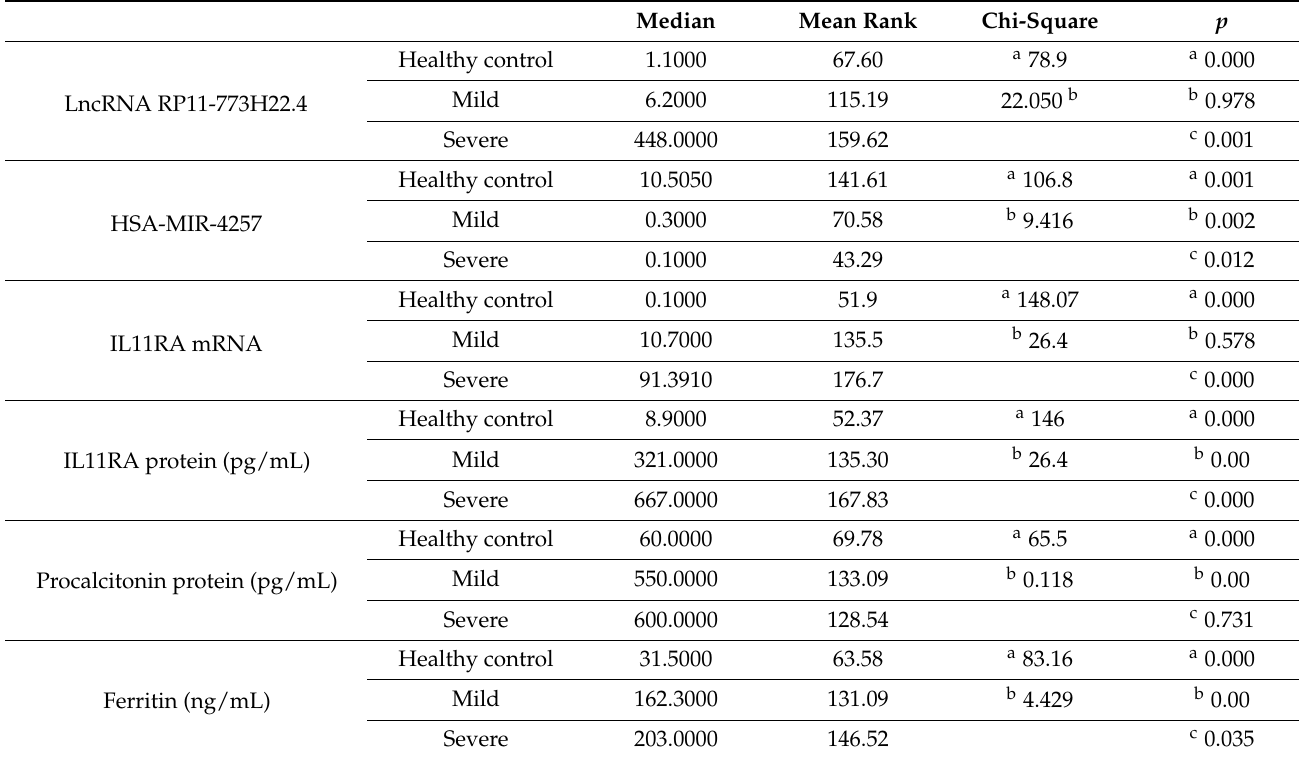
Table 2. The differential expression of various parameters is shown among the different study groups, in addition to severe versus mild